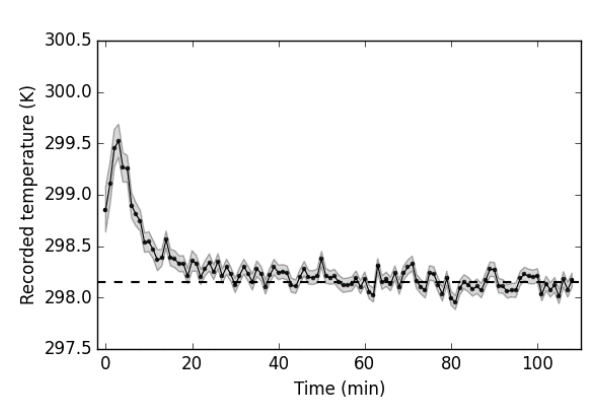
Figure 7. Corrected mean image temperature of a blackbody at 298.15 K (dashed line), as recorded by a camera over time. Shaded areas represent one-sigma standard deviation.